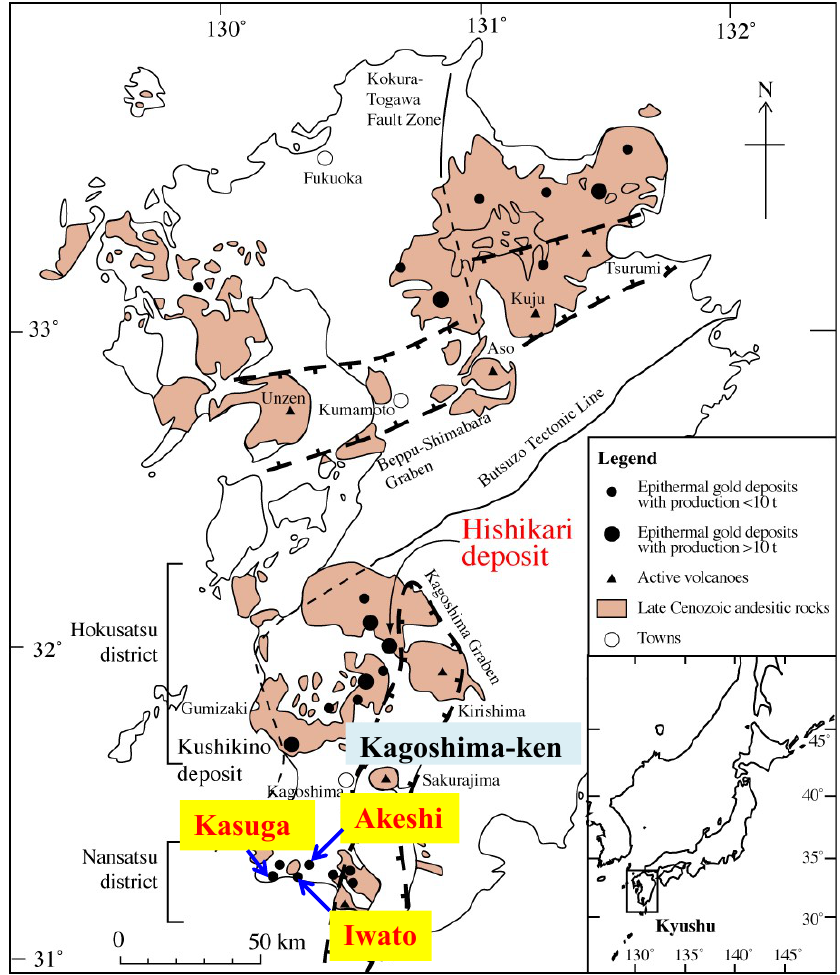
Figure 1. Epithermal gold deposits in Kyushu in Southwestern Japan [23,24]. The location of the Kasuga, Iwato, and Akeshi deposits are shown in addition to the Hishikari deposit.